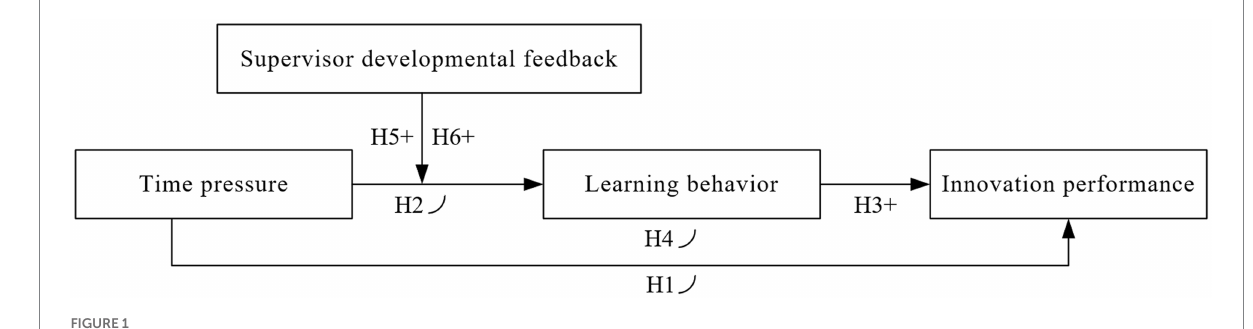
FIGURE 1 Research conceptual